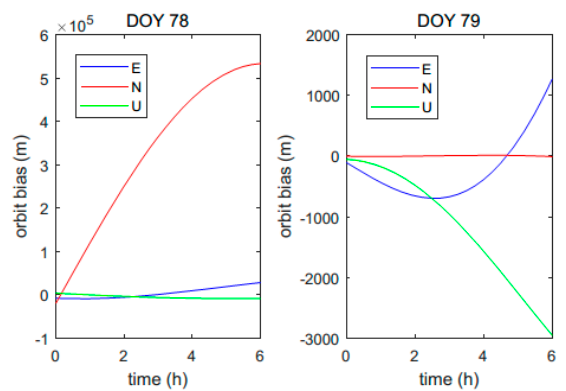
Figure 6. Orbit biases of east, north, and up directions between orbit results calculated with ephemerides before and after maneuvers of C03. Left and right subfigures correspond to results of doy 78 and doy 79, respectively.